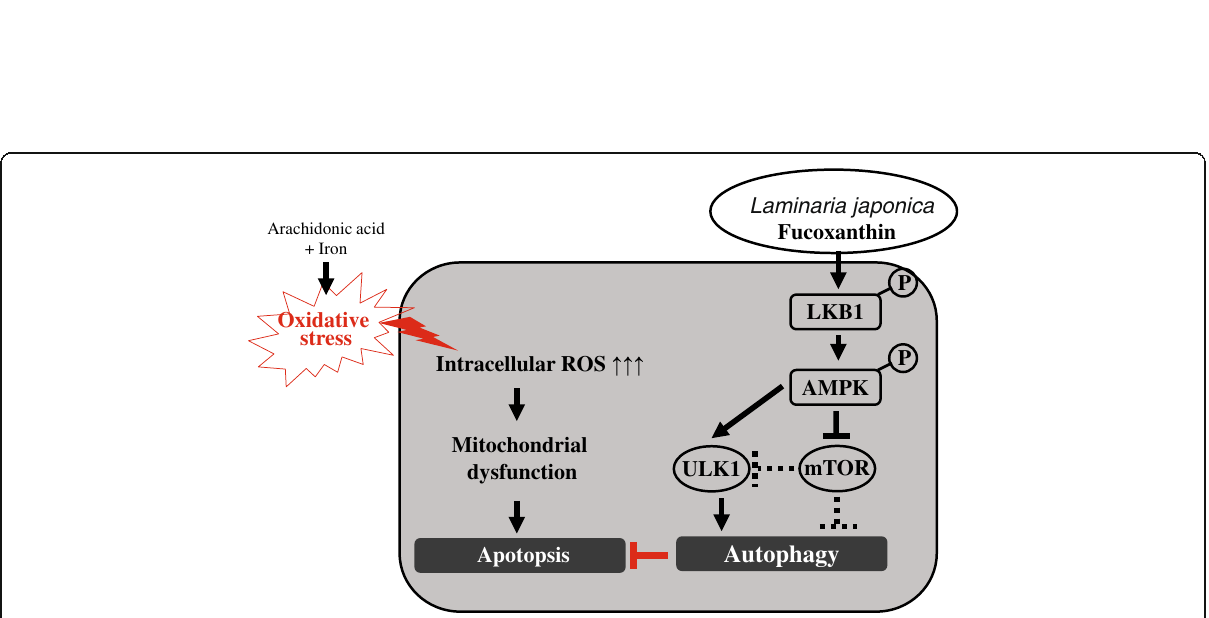
Fig. 7 Schematic diagram showed that FX induces AMPK-mediated autophagy contributing to ameliorates oxidative stress in HepG2